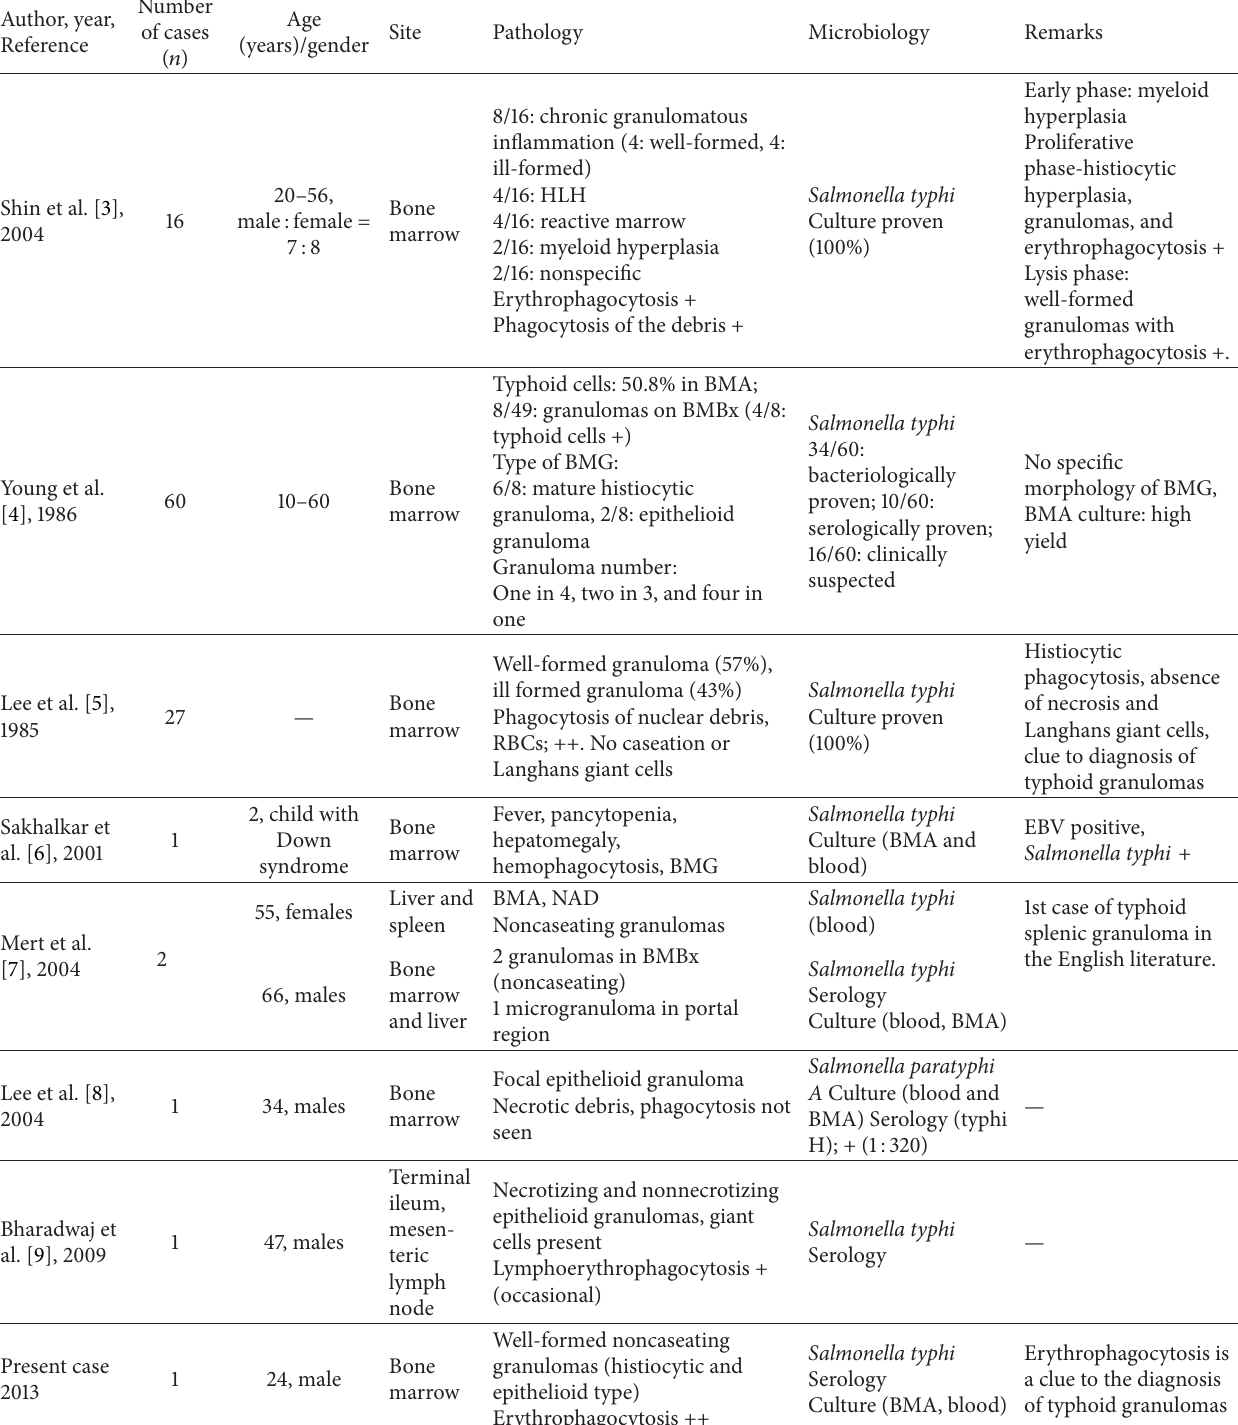
Table 1: Typhoid granuloma: a brief review of the